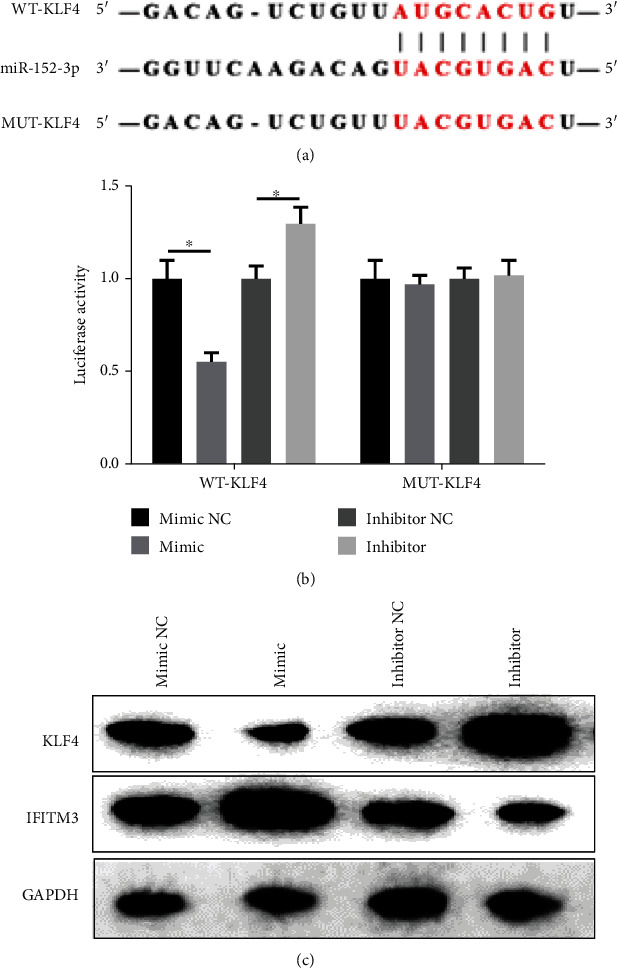
miR-152-3p targets KLF4 and decreases its expression. (a) Binding sites of miR-152-3p on KLF4 3′UTR were predicted by the bioinformatics method. (b) Dual-luciferase assay was done for the validation of the targeting relationship between miR-152-3p and KLF4. (c) Western blot was conducted to test the protein expression of KLF4 and IFITM3 in each treatment group (∗ means p < 0.05).